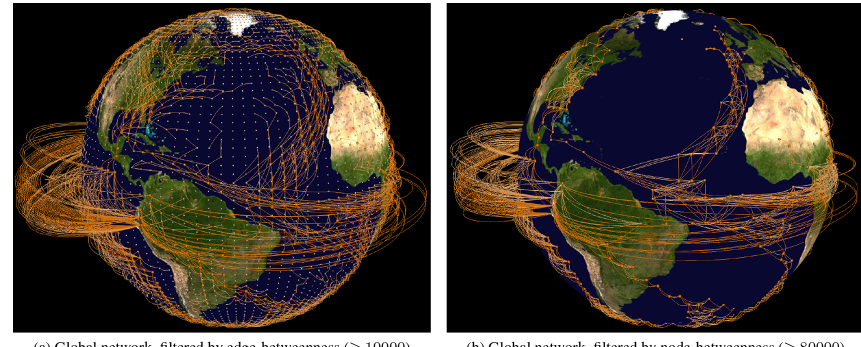
Figure 15. Visualisation of a global surface air temperature climate network using different 2-D map projections (GTX). Filtering has been applied to highlight nodes with large shortest-path betweenness.